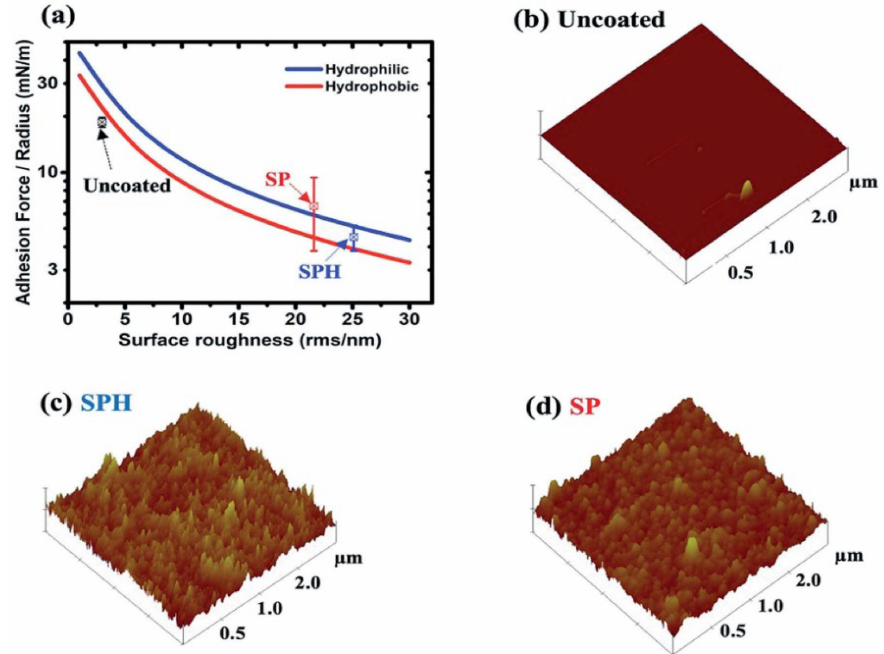
Figure 13. ( a ) Measured and calculated adhesion force between a silica sphere (15 mm diameter) and SP and SPH surfaces. AFM surface morphology analysis of ( b ) uncoated surface, ( c ) SPH coating, and ( d ) SP coating